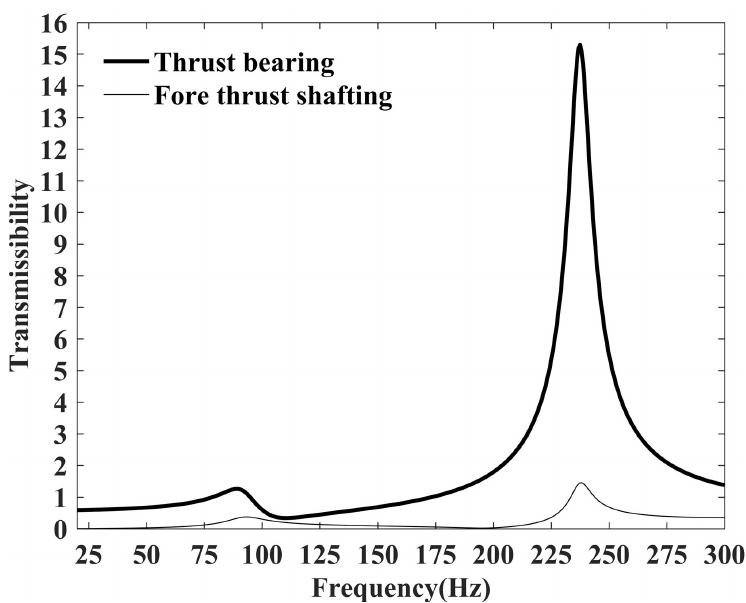
Figure 12. Transmissibility of the thrust bearing and the fore